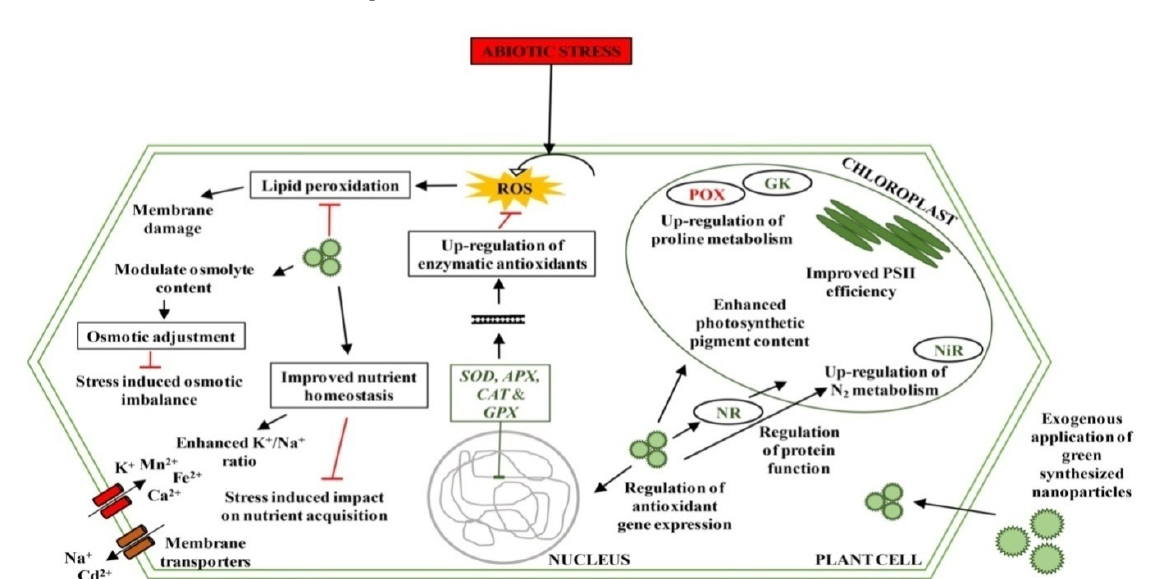
Figure 3. Summarization of cellular parameters regulated by the application of green synthesized nanoparticles to plants under different abiotic stresses. The presented NPs are a generalization of various green synthesized NPs administered in abiotic stressed plants, and reported to impart tol- erance traits by regulating the various cellular/physiological aspects. Membrane transporters bring about nutrient uptake and efflux, the efficiency of which is hampered by various abiotic stress con- ditions but is restored and maintained by green synthesized NPs’ supplementation. Enzymatic an- tioxidants up-regulated by the action of green synthesized NPs aid in ameliorating abiotic stress- induced oxidative damages and maintain cellular homeostasis. Photosynthetic efficiency, nitrogen metabolism and osmolyte concentrations were enhanced upon NPs’ application, and thus play a crucial role in imparting abiotic stress tolerance. Genes and proteins represented in green are up- regulated, while those represented in red are down-regulated. Black arrow lines represent effects imposed by NPs and/or a further step in a natural series of cellular events. Red line with a flat head represents the repression effect. APX , ascorbate peroxidase gene; Ca 2+ , calcium ions; CAT , catalase gene; Cd 2+ , cadmium ions; Fe 2+ , ferrous ions; GK, glutamyl kinase; GPX , glutathione peroxidase gene; K + ; potassium ions; Mn 2+ , manganese ions; Na + , sodium ions; NiR, nitrite reductase; NR, nitrate reductase; NPs, nanoparticles; POX, proline oxidase; ROS, reactive oxygen species; SOD, superox- ide dismutase gene. Green synthesized NPs can significantly alter the enzymatic and non-enzymatic an- tioxidant defense system and thus impact ROS homeostasis. Such amendments in cell functioning can help plants to adapt for the prevention of oxidative damage, especially to cellular membranes. The application of SNPs (0.01–1 mg L − 1 ), synthesized from C. zeylan- icum bark extract, to L. sativa reduced the levels of stress markers such as MDA and H 2 O 2 [79]. Similar results were also reported in Z. mays upon exposure to phytogenic ZnONPs (50 mg L − 1 ) synthesized using plant extract of L. minor [80]. In another experiment, AgNPs (0.05 mg L − 1 ) synthesized from E. globulus improves the overall oxidative defense of Z. mays , A. cepa and T. foenum-graecum via increasing the antioxidant enzymatic activities (CAT, POX and APX) and non-enzymatic antioxidant (AsA and GSH) contents [82]. Fur- thermore, there was a reduction in MDA content, which highlighted the efficiency of green synthesized AgNPs in membrane stabilization, associated with decreased lipid pe- roxidation and oxidative stress-induced adversities. In addition, defensive enzymatic ac- tivities such as PPO, PAL, SOD, POX, APX, and CAT were increased at 0.05 mg mL − 1 in L. sativa upon the exogenous application of green synthesized CuONPs [87]. Peroxidase and CAT activities were also reported to be up-regulated in L. usitatissimum treated with Fe 2 O 3 NP (1000 mg L − 1 ), biosynthesized using the flower extract of H. paniculata [86]. Ab- basifar et al. [85] reported that the synergistic effect of biosynthesized ZnNPs + CuNPs (1000, 2000 and 4000 ppm) showed improved antioxidant capacity in O. basilicum.